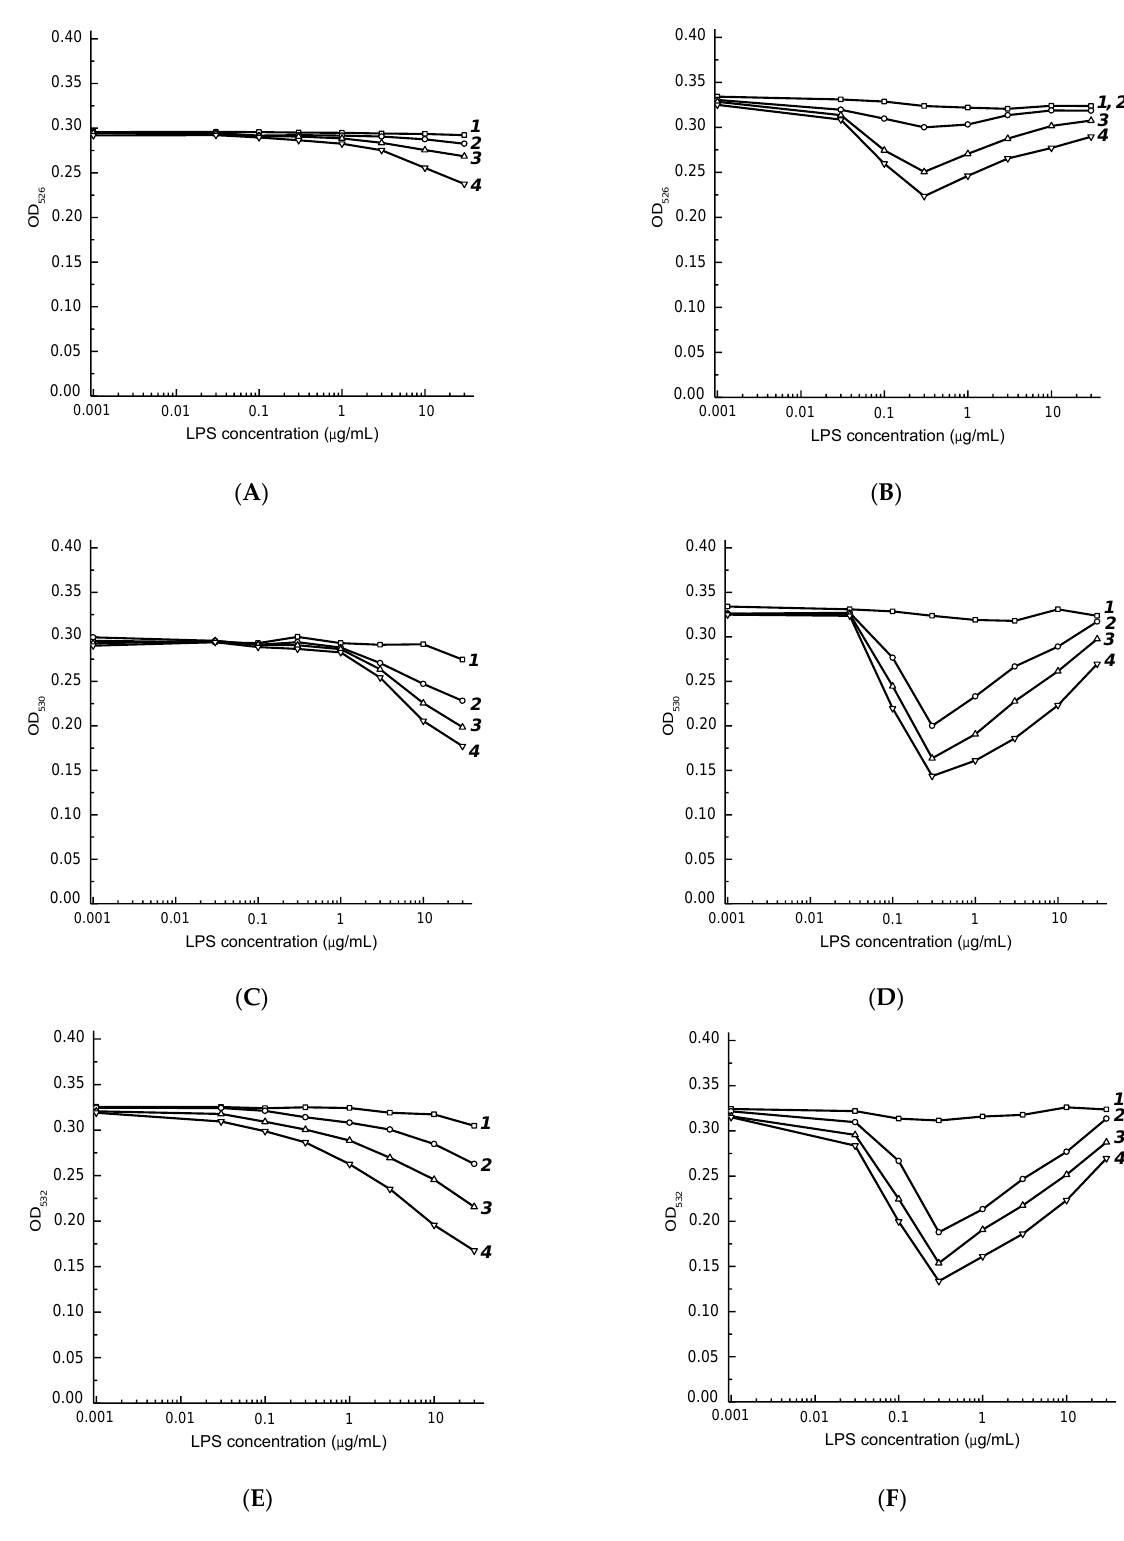
Figure 3. Agglutination of AuNPs1 – Fb11 ( A ), AuNPs1 – T143 ( B ), AuNPs2 – Fb11 ( C ), AuNPs2 – T143 ( D ), AuNPs3 – Fb11 ( E ), and AuNPs3 – T143 ( F ) conjugates in the presence of various concentrations of F. tularensis LPS. Curves 1 – 4 correspond to 1, 10, 20, and 30 min of the reaction.